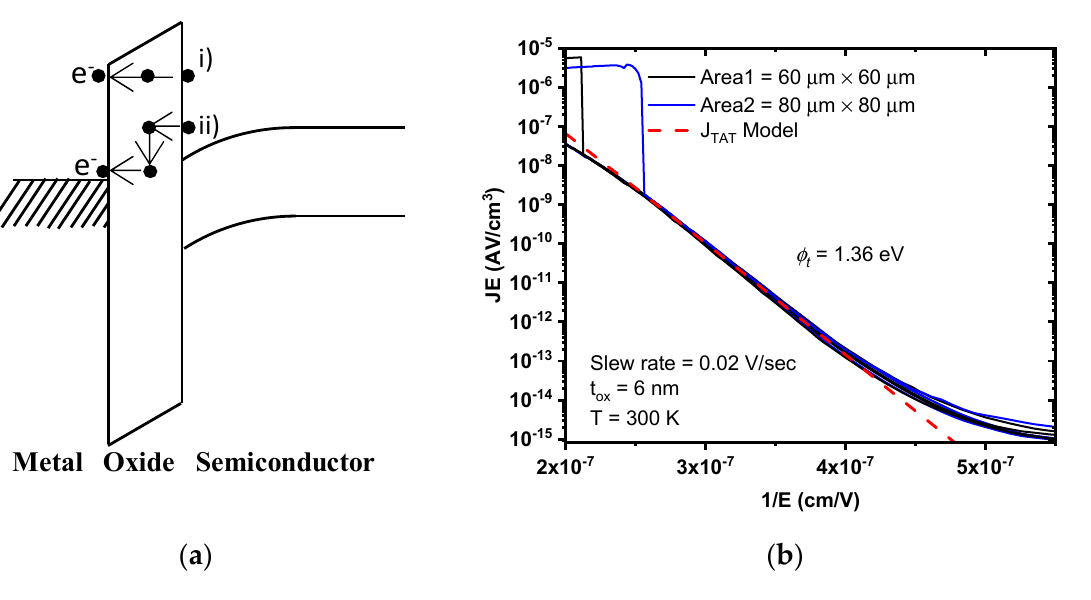
Figure 6. ( a ) Band energy diagram for TAT and ( b ) comparison of JE vs. 1 /E results from measured data and current density due to the TAT model.